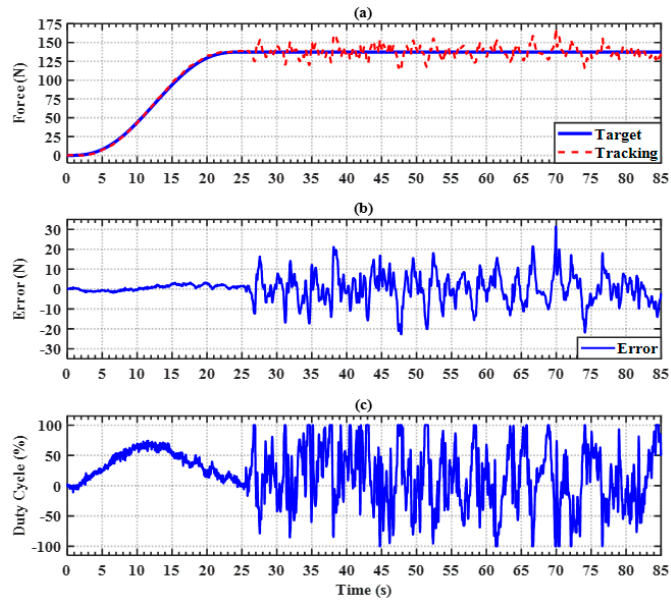
Figure 14. Dynamic bodyweight unloading force control of ILESO − PSMC, 20% (137.2 N) of participant body weight (686 N). ( a ) Unloading force tracking response; ( b ) unloading force tracking error; ( c ) duty cycle of PWM.